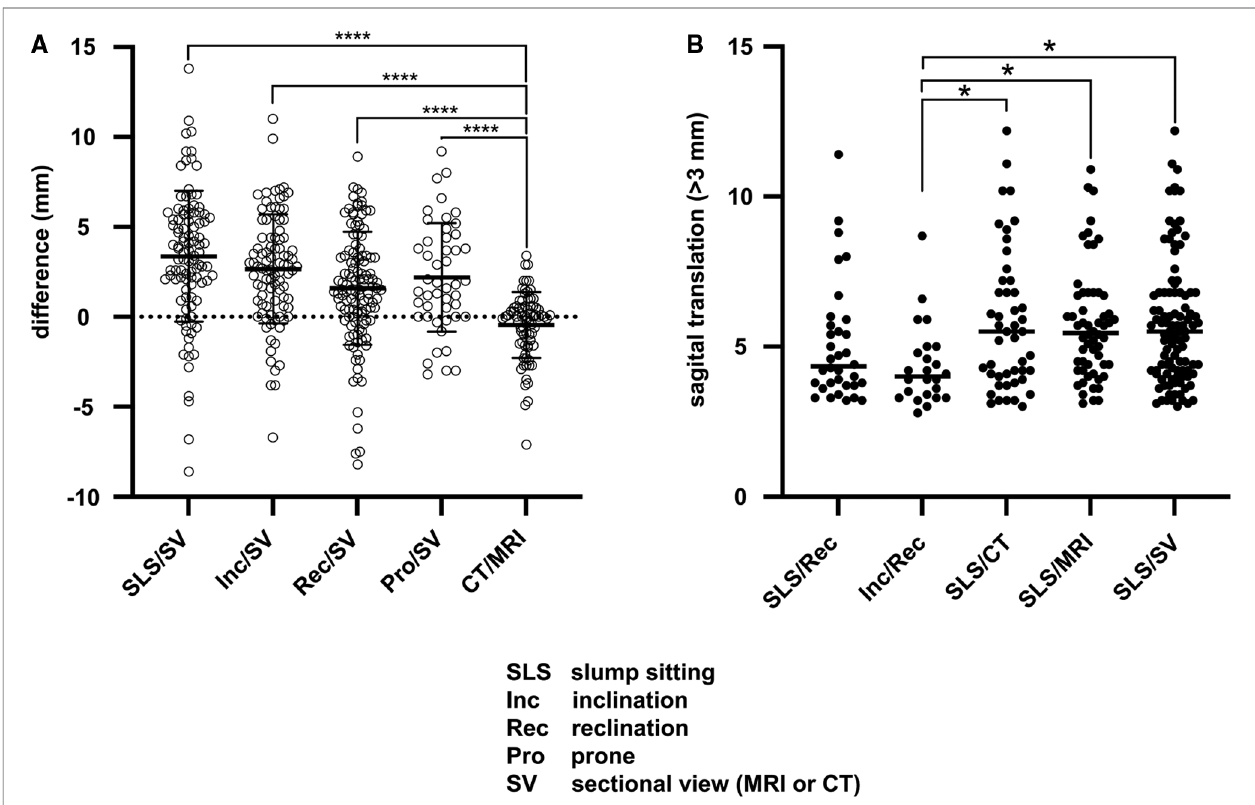
FIGURE 3 | Mean difference of sagittal translation between different imaging modalities ( A ). Detection rate of pathological translation larger than 3 mm ( B